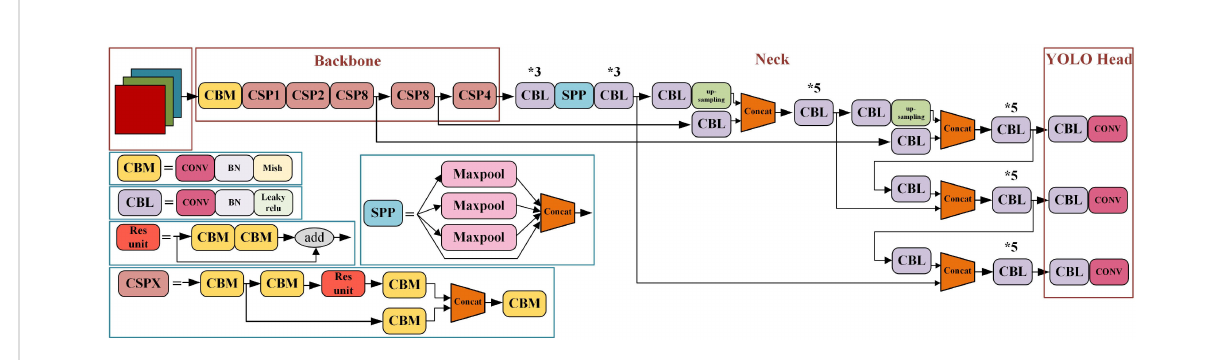
FIGURE 2 YOLOv4 network structure diagram. * means repeat the operation.